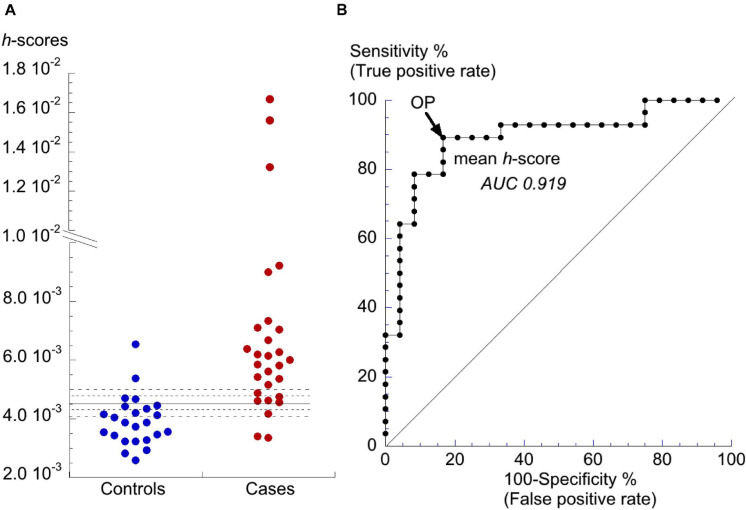
Distribution of h-scores and final discriminant analysis. (A) Dot-plot of h-scores for controls and cases. The horizontal line is the value for h that optimally separates data from the controls and cases cohorts. The dotted lines represent ±5 and ±10% changes to the h-score. (B) ROC curve for h-scores to discriminate between controls and cases cohorts. AUC value shown by the curve. The operating point (OP) is shown by the arrow.